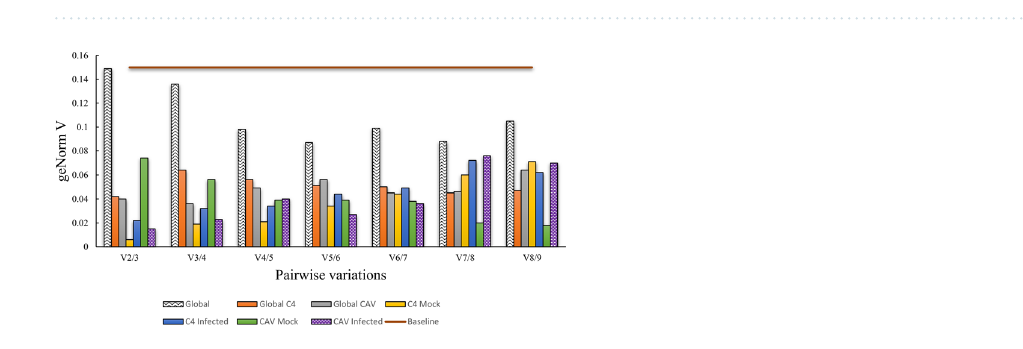
Figure 4. GeNormV-derived determination of the optimal number of reference genes for accurate RT-qPCR normalization of target gene expression. For data below a cutoff value of 0.15, the inclusion of additional reference genes will not contribute significantly to the normalization of gene expression